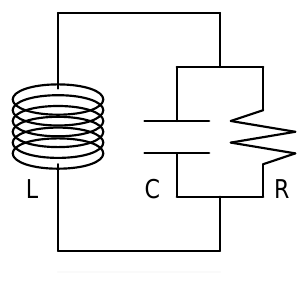
Figure 4. The sensor is modeled as an inductor L and capacitor C connected in series. The capacitor loss is represented by the resistor R